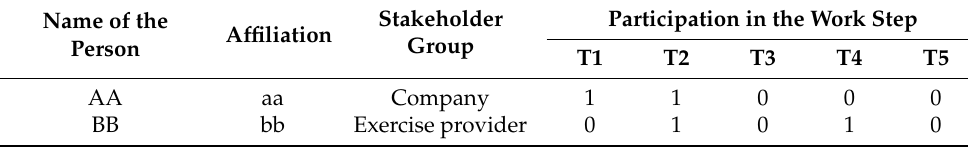
Table 2. Data collection table